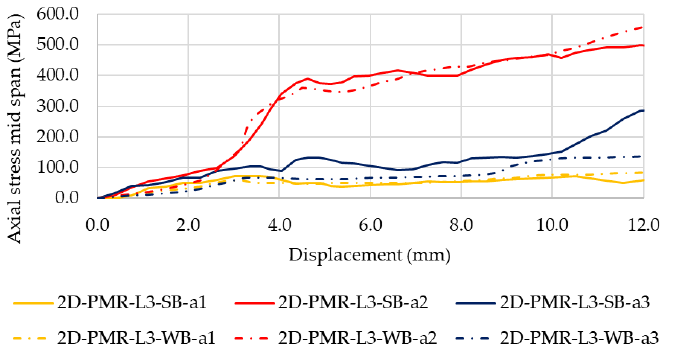
Figure 10. Numerical models 2D-PM-L3-SB and 2D-PM-L3-WB: axial stress at the steel connectors ( a 1 , a 2 , a 3 ), mid-span versus the plate vertical displacement